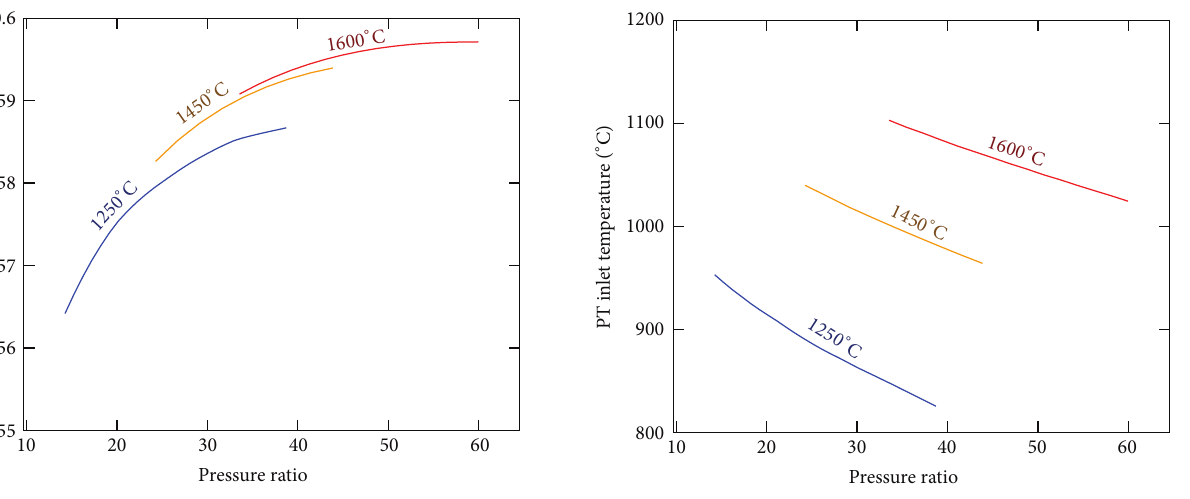
Figure 12: Power turbine entry temperature as function of pressure ratio and turbine entry temperature for the Graz cycle.